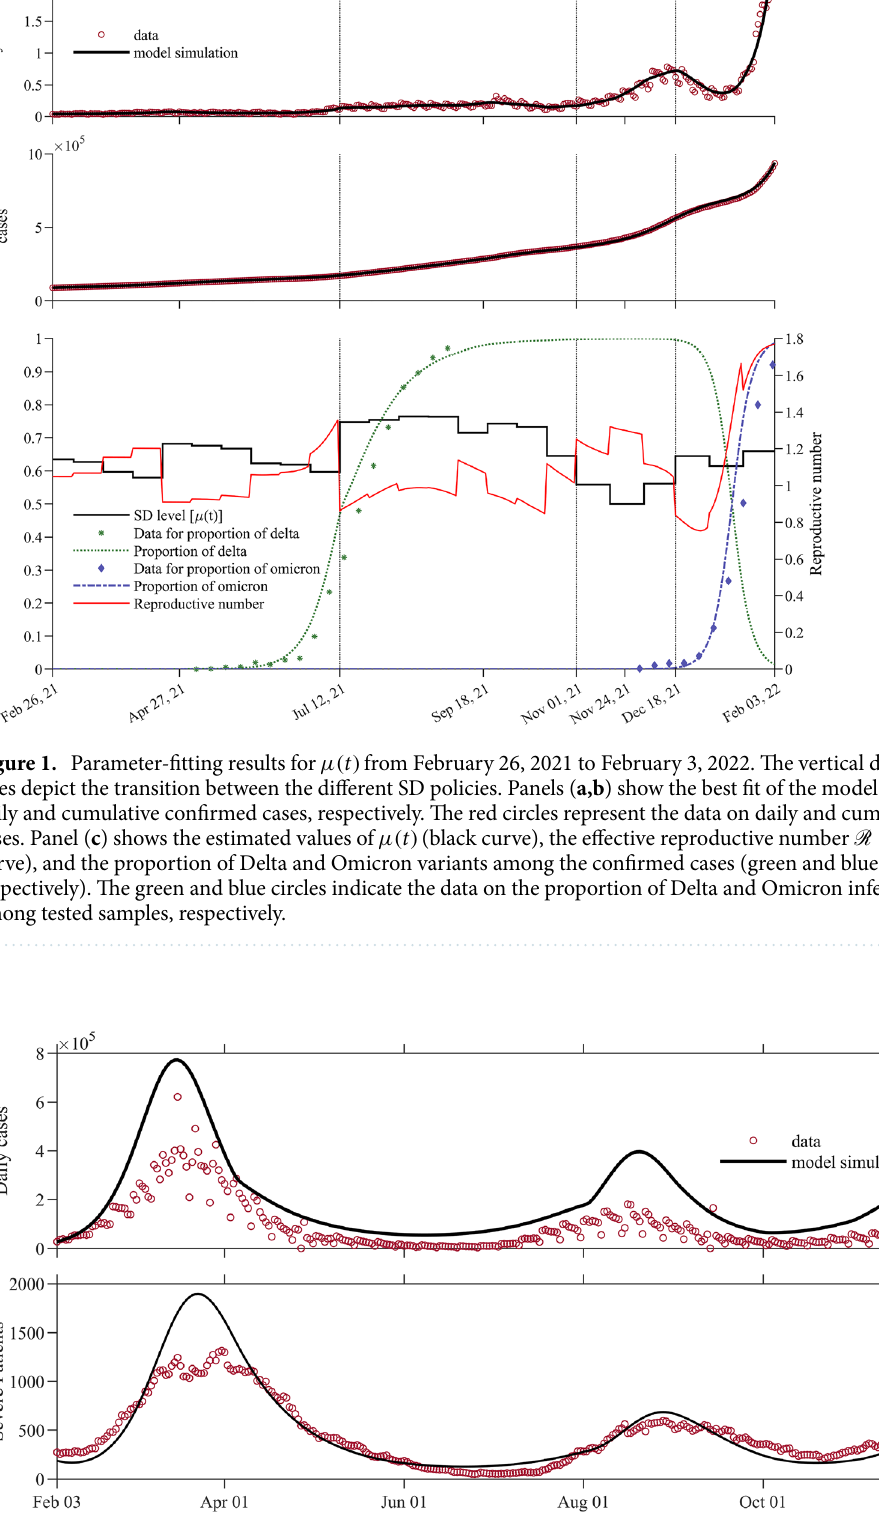
Figure 2. Comparison of the model simulations with the data from February 3 to November 30, 2022. Panel ( a,b ) show the daily confirmed cases and severe patients, respectively. The data are represented by the red